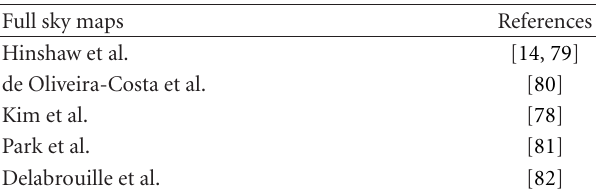
Table 1: Full-sky foreground-cleaned CMB maps from WMAP data used in our analysis to estimate the variable y (see the text for more details). Note that the reference [78] includes the analysis of maps from the three- and five-year WMAP